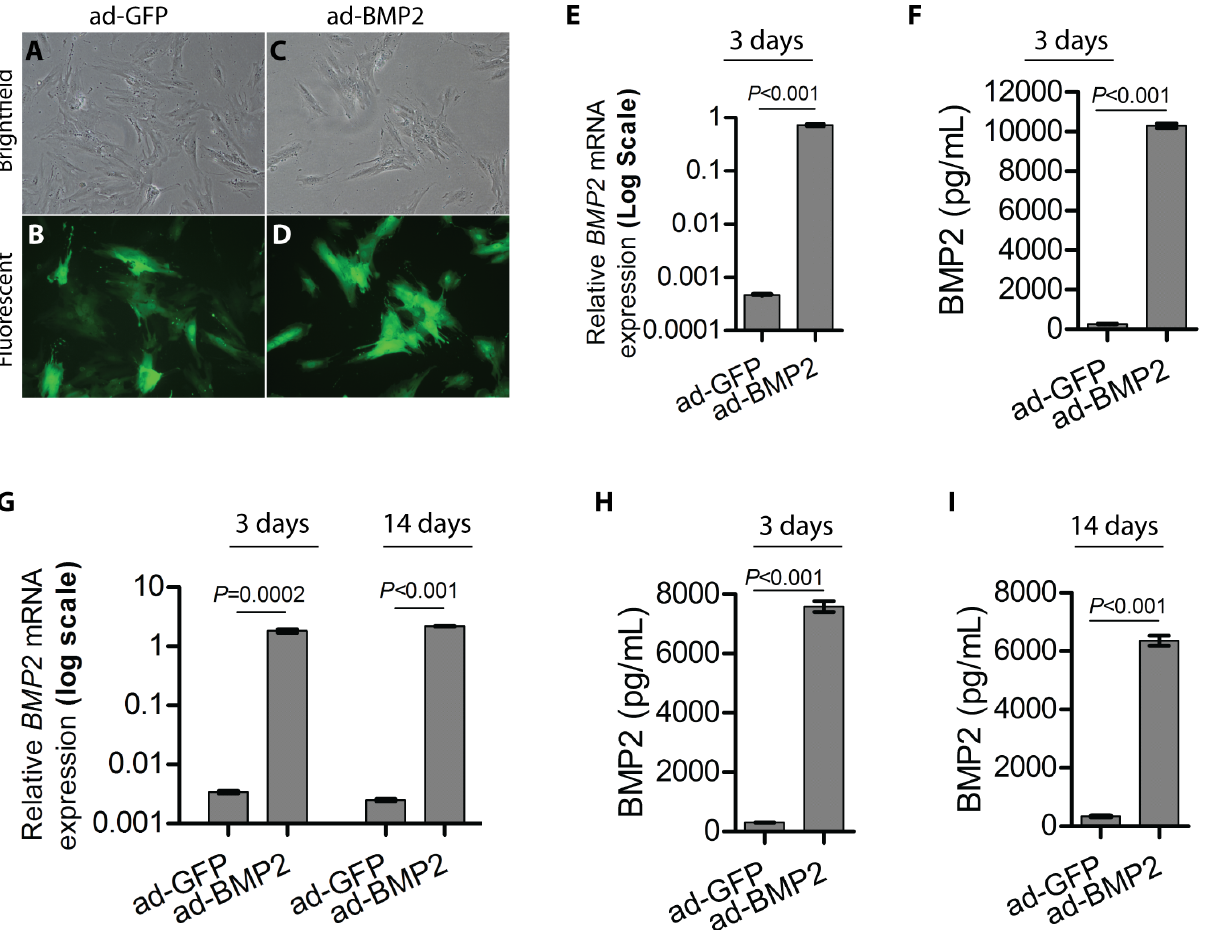
Fig 1. BMP2 adenoviral expression vector increased up-regulation of BMP2 in BMSC. Representative images of BMSC in monolayer transduced with ad-GFP (A, brightfield and B, fluorescent) and ad-BMP2 (C, brightfield and D, fluorescent) adenoviral particles. Significant up-regulation of BMP2 mRNA (E) and secreted BMP2 protein in the conditioned medium (F) at day 3 in ad-BMP2 BMSC in monolayer as compared to the ad-GFP BMSC. Error bars in (E) represent SEM of 3 repeated experiments ( n = 3) done in 3 technical replicates. Student ’ s-t test was performed for statistical analysis. Error bars in (F) represent SEM of 3 repeated experiments. Student ’ s t -test was performed for statistical analysis. (G) 5× 10 4 BMSC were seeded in each poly(LLA-co-CL) scaffolds and harvested after 3- and 14-days for qRT-PCR. qRT-PCR demonstrated significant up-regulation of endogenous BMP2 mRNA in ad-BMP2 BMSC as compared to the ad-GFP BMSC both at 3- and 14- days. BMP2 mRNA level was normalized to GAPDH mRNA level. Error bars represent SEM of 3 repeated experiments ( n = 3) done in 3 technical replicates. Student ’ s t -test was performed for statistical analysis. (H-I) Higher levels of secreted BMP2 were observed by using ELISA assay in the culture supernatant of ad-BMP2 BMSC as compared to the ad-GFP transduced cells both at 3- and 14- days. Error bars in (H and I) represent SEM of 3 repeated experiments. Student ’ s t -test was performed for statistical